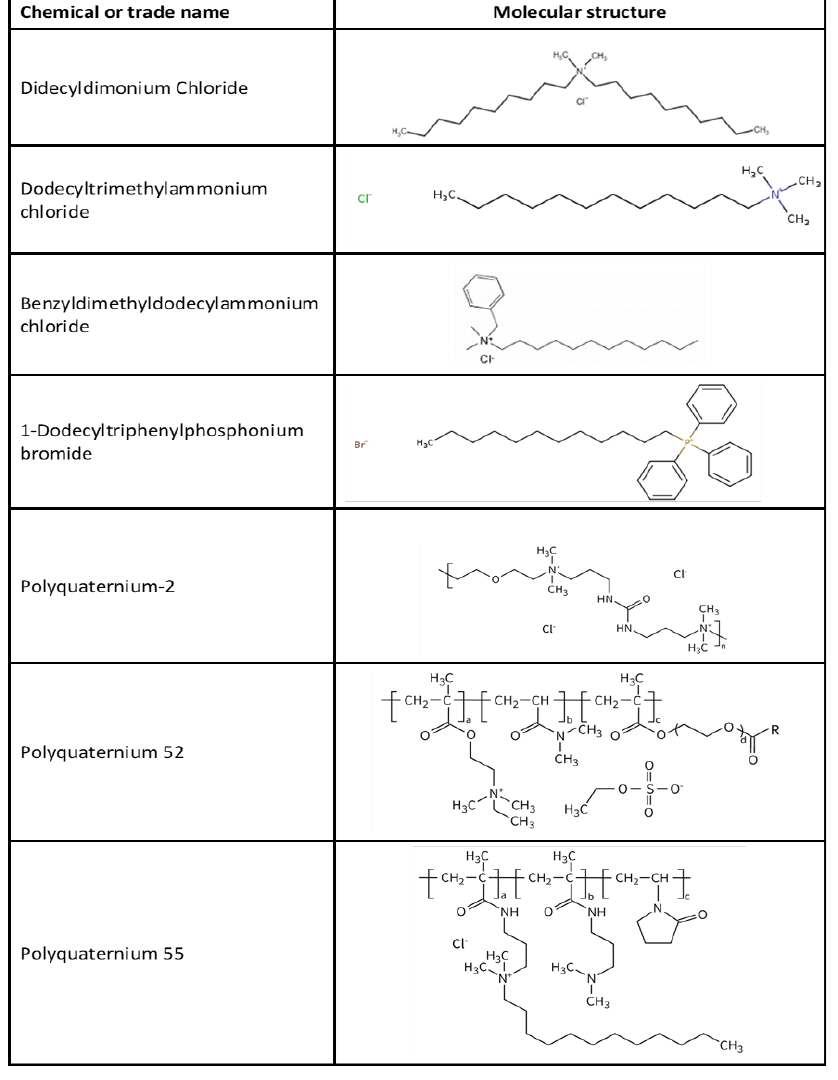
Figure 1. The chemical or trade names and molecular structure of the diverse cationic molecules studied in this work.